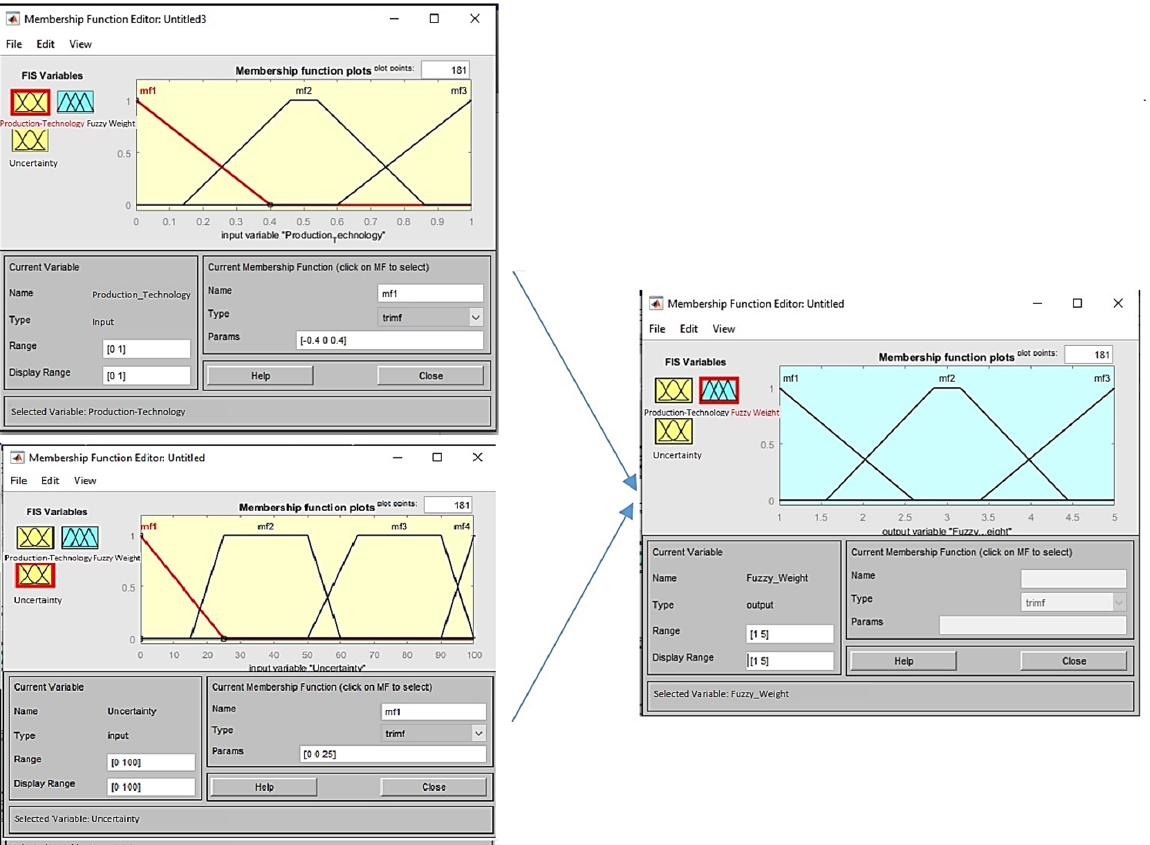
Figure 6. The expanded FIS model with ranges and fuzzy members.